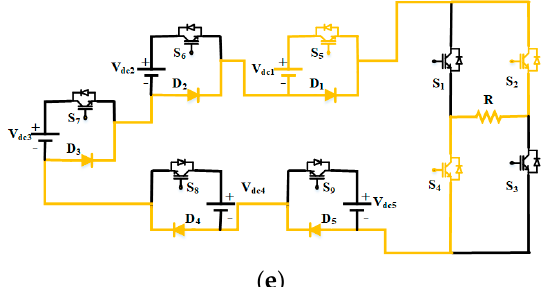
Figure 18. ( a – e ) Equivalent circuit for different modes during negative cycle of output voltage . The pulse pattern waveform and the output voltage waveform simulated in MATLAB/SIMULINK are given in Figure 19.